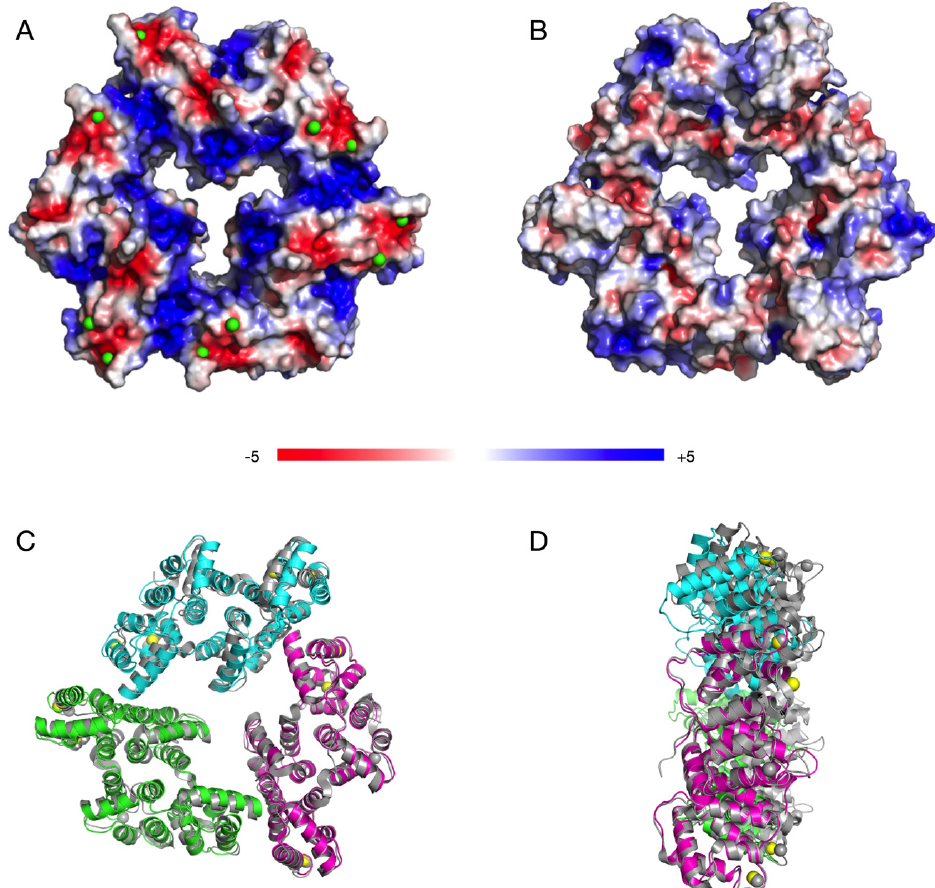
Figure 5. Trimeric assembly of AnxA11 in the crystal. ( A ) AnxA11 trimer surface coloured with electrostatic potential. The view from the Ca 2+ -binding face. Ca 2+ ions are shown as green spheres. The negative sites (red) are the locations for Ca 2+ binding, and their neutralization will make the surface very positive, enabling lipid membrane binding. ( B ) The opposite face of AnxA11 is relatively featureless. ( C ) Superposition of AnxA11 (coloured) with the AnxA5 trimer (gray) [64]. Superposition was done based on one monomer (bottom right) to better highlight possible differences in assembly. The view is the same as in ( B ). ( D ) Side view of the superimposed AnxA11 and AnxA5